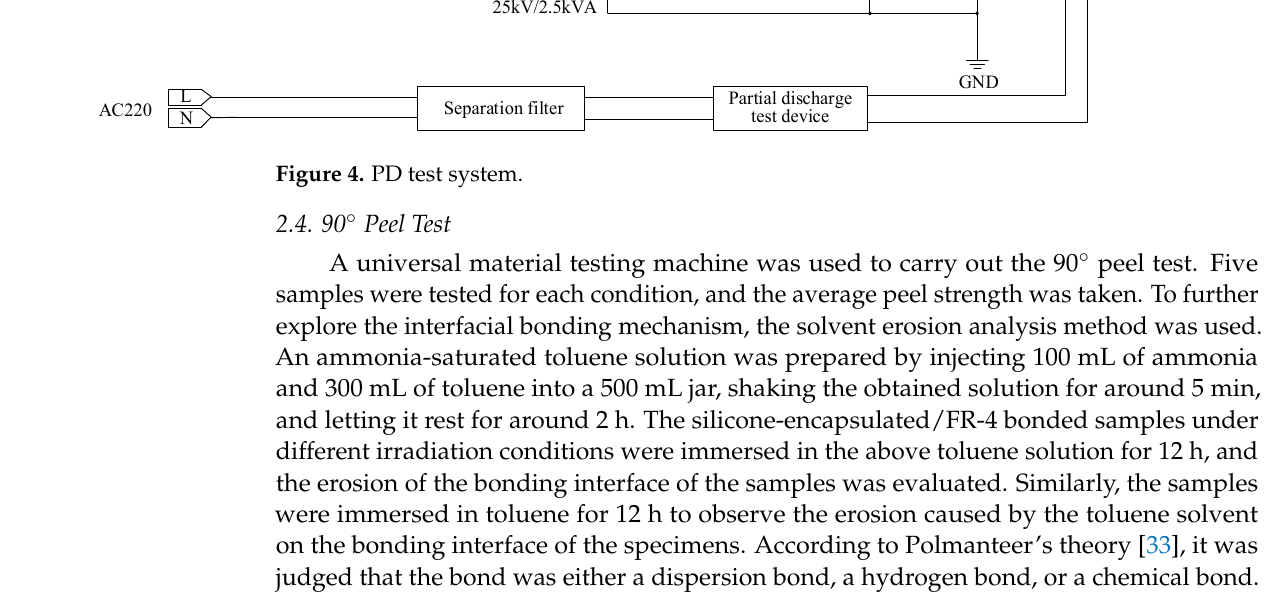
Table 1. Samples for the physical property tests, standards, test conditions and test equipment.